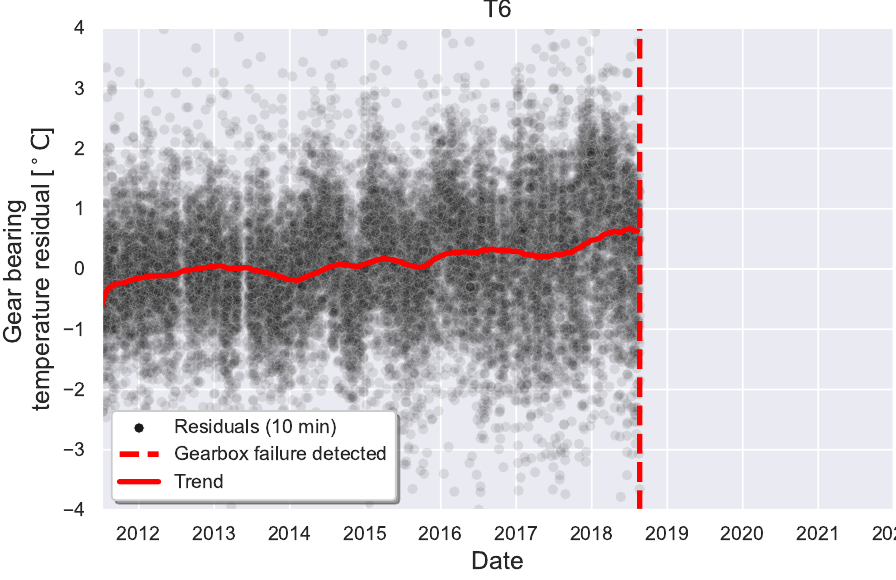
Figure 6. Evolution of the residual over time. Black dots represent the original raw values of the residuals. The solid line represents the trend. The vertical dashed line represents the failure